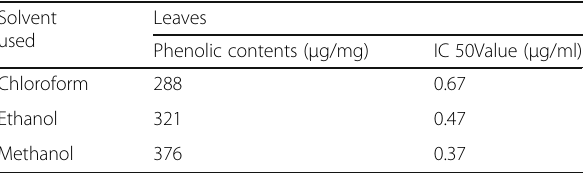
Table 2 Phenolic content and IC 50 value in O. ferruginea stem